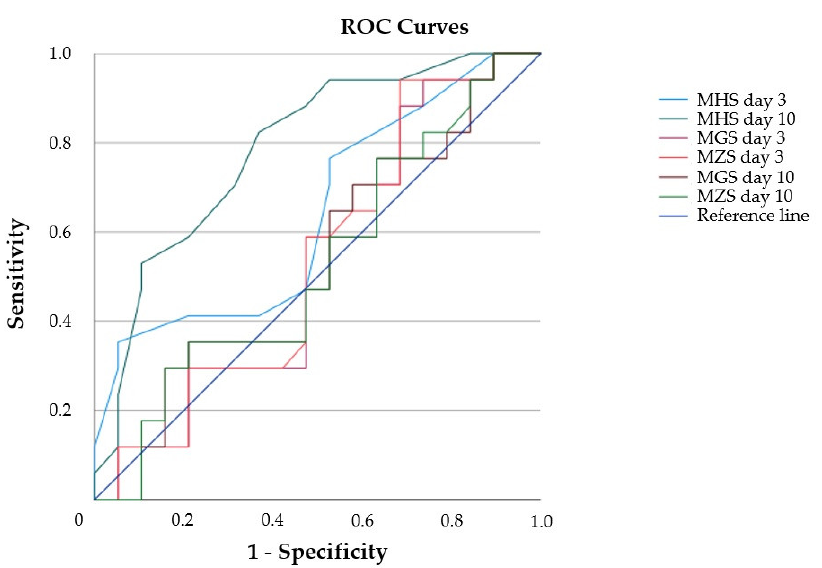
Figure 4 . ROC curves of ultrasonographic parameters on study days 3 and 10. MGS: global mean greyscale score. MHS: global mean Heckmatt score. MZS: global mean z-score. ROC: receiver operating characteristics.